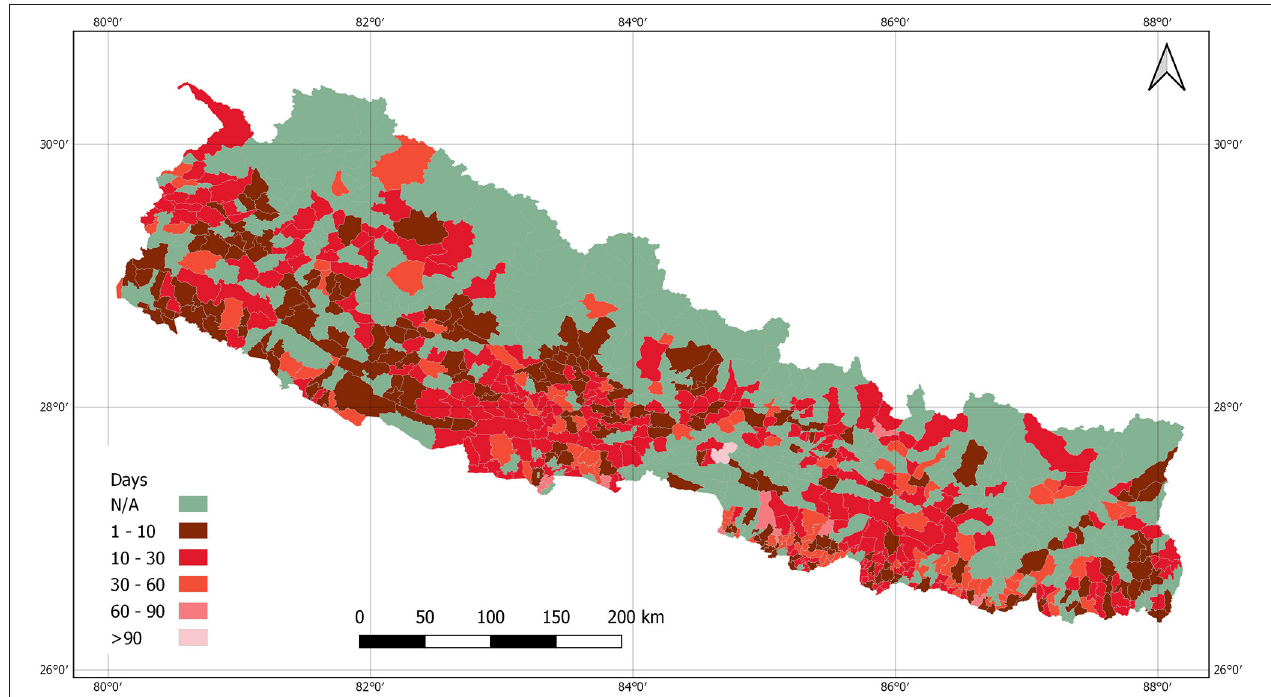
FIGURE 6 | Number of days since the last case reported on the day of lockdown lifted.